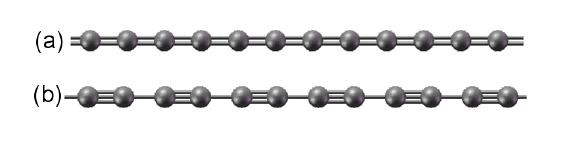
Figure 1: Schematic structures of infinite, linear, sp-carbon wires: (a) equalized wire with all double bonds (cumulene) and (b) alter- nating single–triple bond wire structure